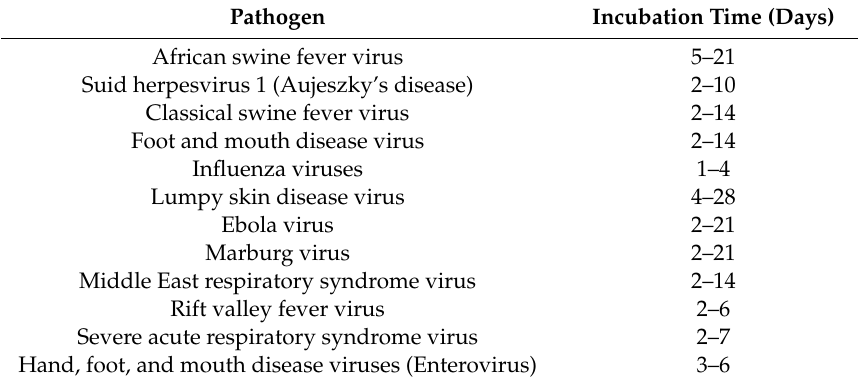
Table 1. Incubation Times of Selected Important Zoonotic and Animal